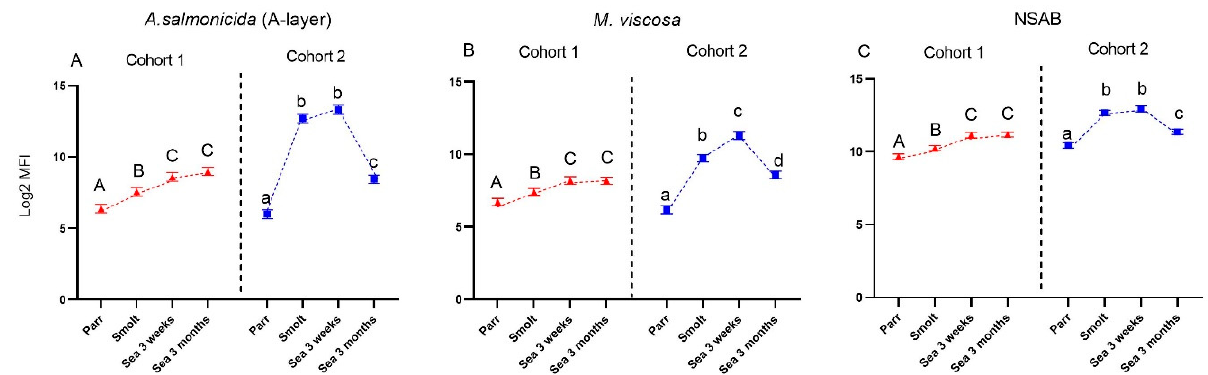
Figure 4. Multiplex immunoassays. Levels of circulating specific antibodies against A-layer of A. salmonicida ( A ) and M. viscosa whole-cell sonicate ( B ), and nonspecific antibodies (NSAB) ( C ). Data are displayed as mean log 2 MFI (median fluorescent intensity) + SEM (n = 12–15 individuals at each time-point). Data points within one cohort not sharing the same letters are significantly different (ANOVA, LSD test, p < 0.05).